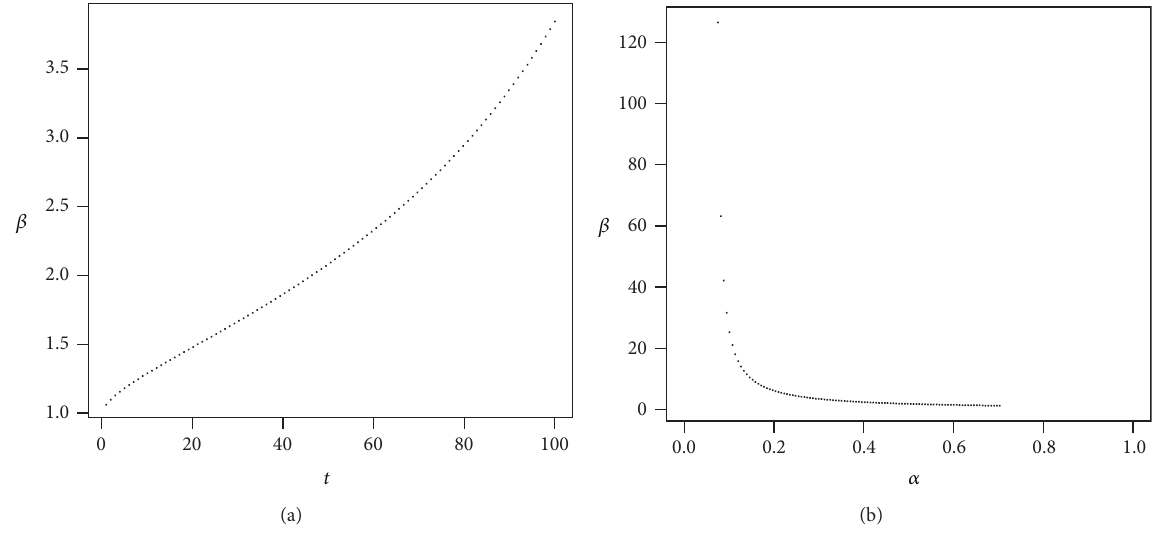
Figure 6: Medium volatility of returns (breakeven). The plot shows 𝛽 as a function of 𝑡 with 𝛼 = 50 % (a) and 𝛽 as a function of 𝛼 with 𝑡 = 40 (b). Parameters are 𝑟 = 4 %, 𝜇 = 9.5 %, 𝜎 = 25 %, ] = 1.1 %, and 𝛾 = 10 %.